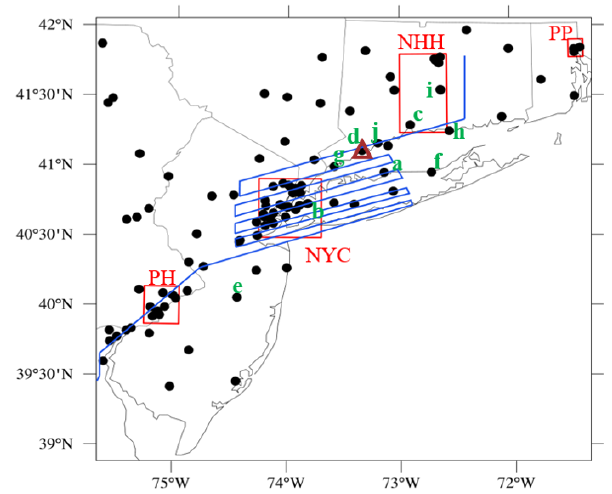
Figure 1. Study area over the Long Island Sound and surround- ing areas. Red boxes depict four subdomains: New York City (NYC), Philadelphia (PH), New Haven–Hartford region (NHH) and Providence–Pawtucket region (PP). Black circles indicate the loca- tions of EPA ground air quality monitors, the brown triangle in- dicates the TOLNet O 3 site located in Westport, CT, and the blue lines present an example flight path conducted by the NASA B200 aircraft on 28–29 August 2018. Letters a–j indicate surface moni- toring sites at (a) Flax Pond, (b) Queens College, (c) New Haven, (d) Westport, (e) Colliers Mills, (f) Riverhead, (g) Greenwich, (h) Madison-Beach Road, (i) Middletown-CVH-Shed and